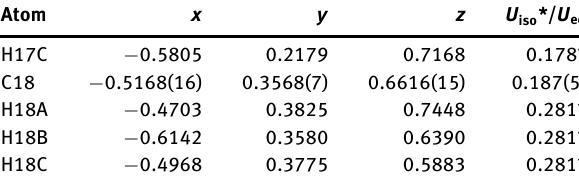
Table 2: Fractional atomic coordinates and isotropic or equivalent isotropic displacement parameters (Å 2